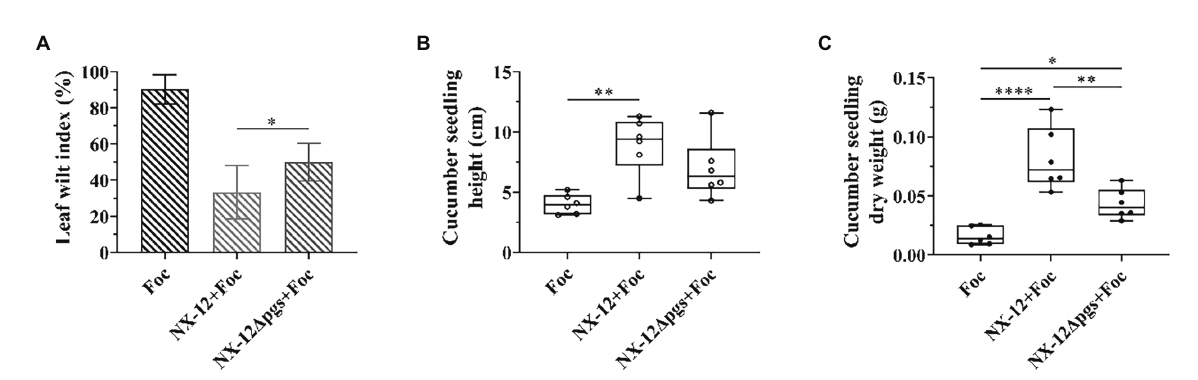
FIGURE 5 The biological control ability of NX-12 Δ pgs decreased significantly. (A) The leaf wilt index (LWI) under different treatments; (B) Seeding height of cucumber treated by NX-12 and NX-12 Δ pgs in controlling Fusarium wilt; (C) Seeding dry weight of cucumber treated by NX-12 and NX-12 Δ pgs in controlling Fusarium wilt. Error bars represent standard deviations. * indicated value of p < 0.05; ** indicates value of p < 0.01; **** indicates value of p <